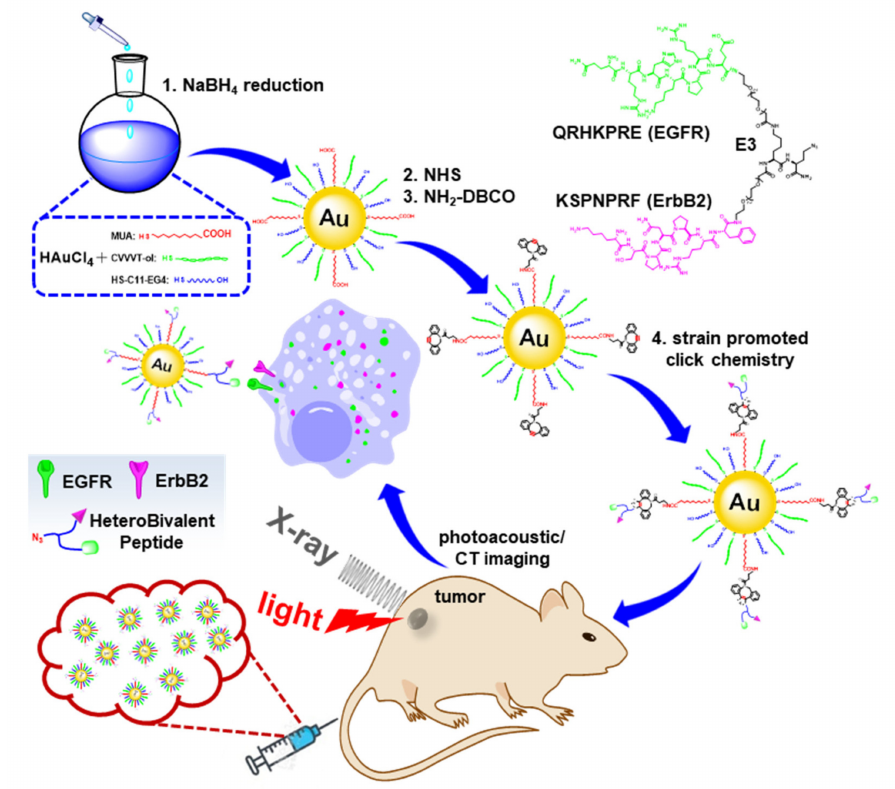
Figure 1. Schematic is shown for labeling the thin layer-protected gold nanoparticles with the heterobivalent (HB) peptide-specific for epidermal growth factor receptors (EGFR) and ErbB2 (HB- Au-NPs) developed for dual photoacoustic/CT imaging.